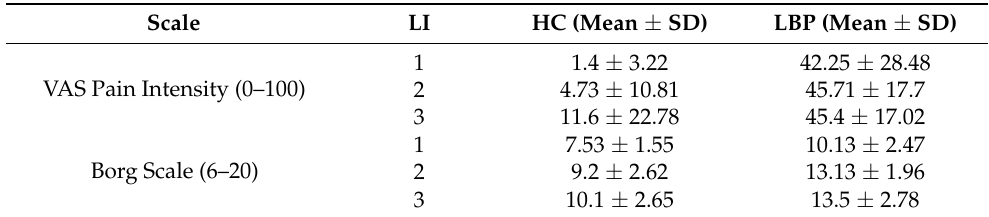
Table 2. Pain and fatigue scores measured at the end of each lifting task. VAS, visual analogue scale (0–100); HC: healthy controls; LBP: Low Back Pain participants; LI, Lifting Index. Values are presented as mean ±